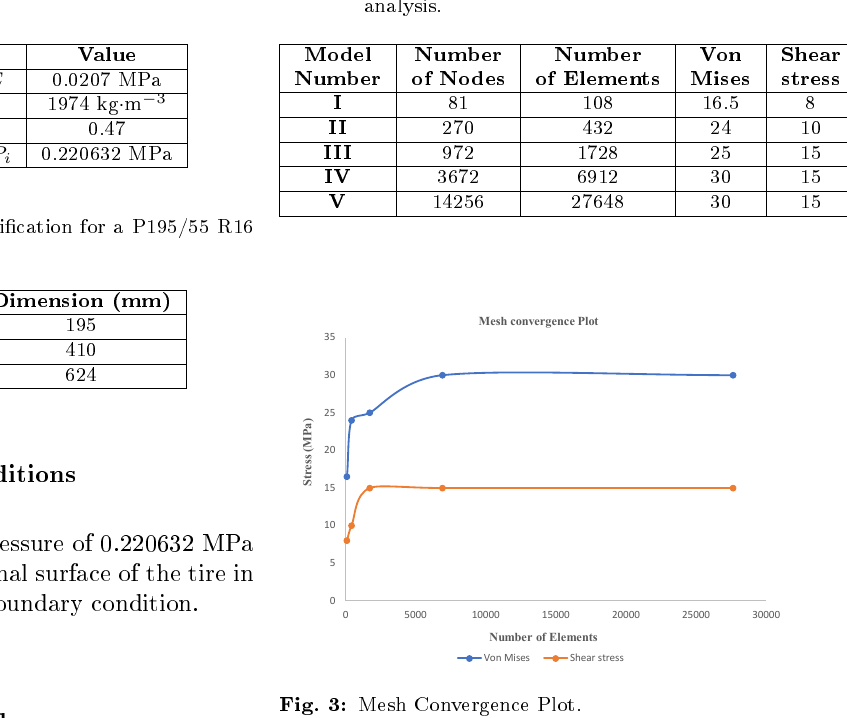
Tab. 1: Material properties of NR/TSO modi(cid:28)ed kaolin composites.